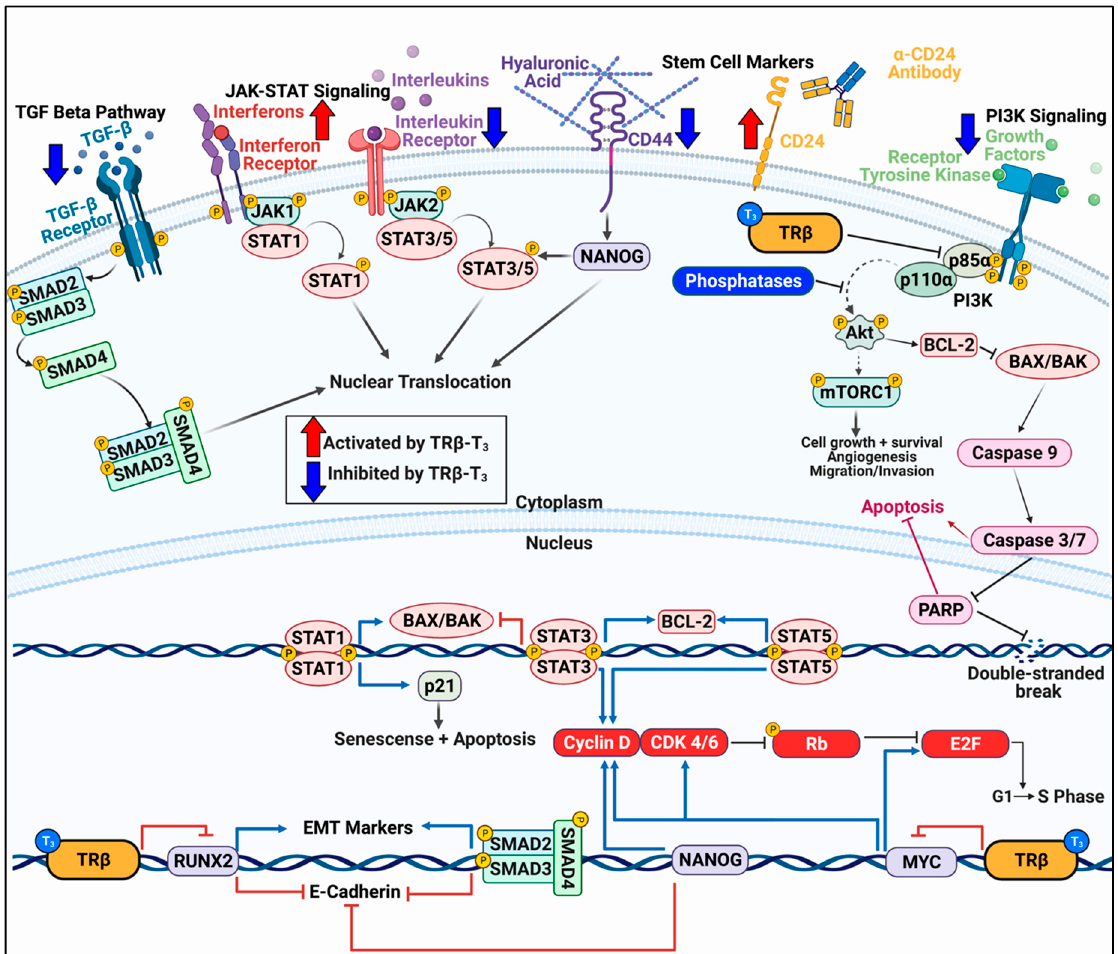
Figure 2. TR β regulates various oncogenic signaling pathways in cancer models that govern cell proliferation, migration, and apoptosis. TR β has shown to be a significant regulator of various oncogenic cell signaling pathways in diverse models of normal and cancer cells. TR β decreases TGF- β signaling resulting in decreased SMAD phosphorylation and transcription of EMT markers. TR β differentially regulates JAK-STAT signaling pathways which results in decreased STAT3 signaling and enhanced STAT1 response to induce apoptosis. TR β activation can reduce the cancer stem cell population as evident by decreased levels of CD44 and increased CD24 in breast and thyroid cancer models, leading to attenuated NANOG levels. TR β also has potent inhibitory effects on PI3K signaling whether via direct binding to the p85 α subunit or through genomic mechanisms to increase transcripts of phosphoinositol phosphatases and decrease receptor tyrosine kinases. TR β also modulates cell cycle genes in various cancer models to enhance expression and phosphorylation of Rb to stall the cell cycle. These potent effects on cancer cell transcriptional reprogramming allow for enhanced efficacy of targeted inhibitors on the PI3K pathway and cell cycle.